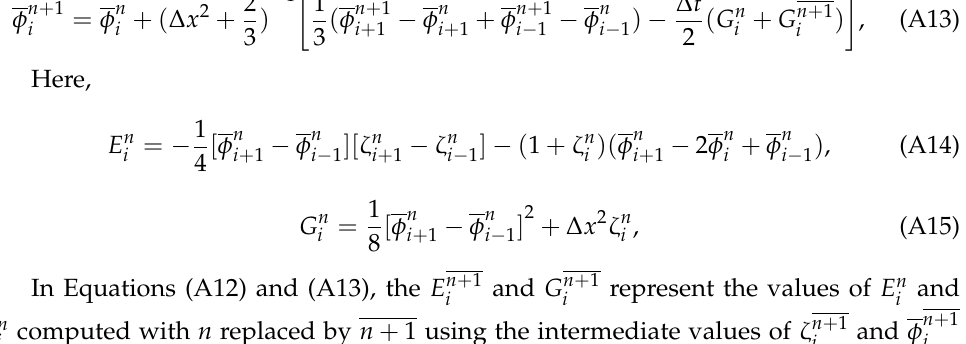
Δ t / Δ x = 0.1/0.15 Δ t / Δ x = 0.1/0.25